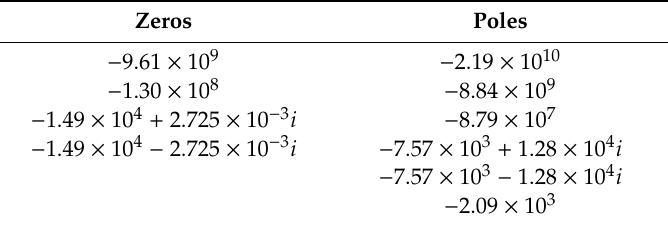
Table 2. Zeros and poles of the looped system.